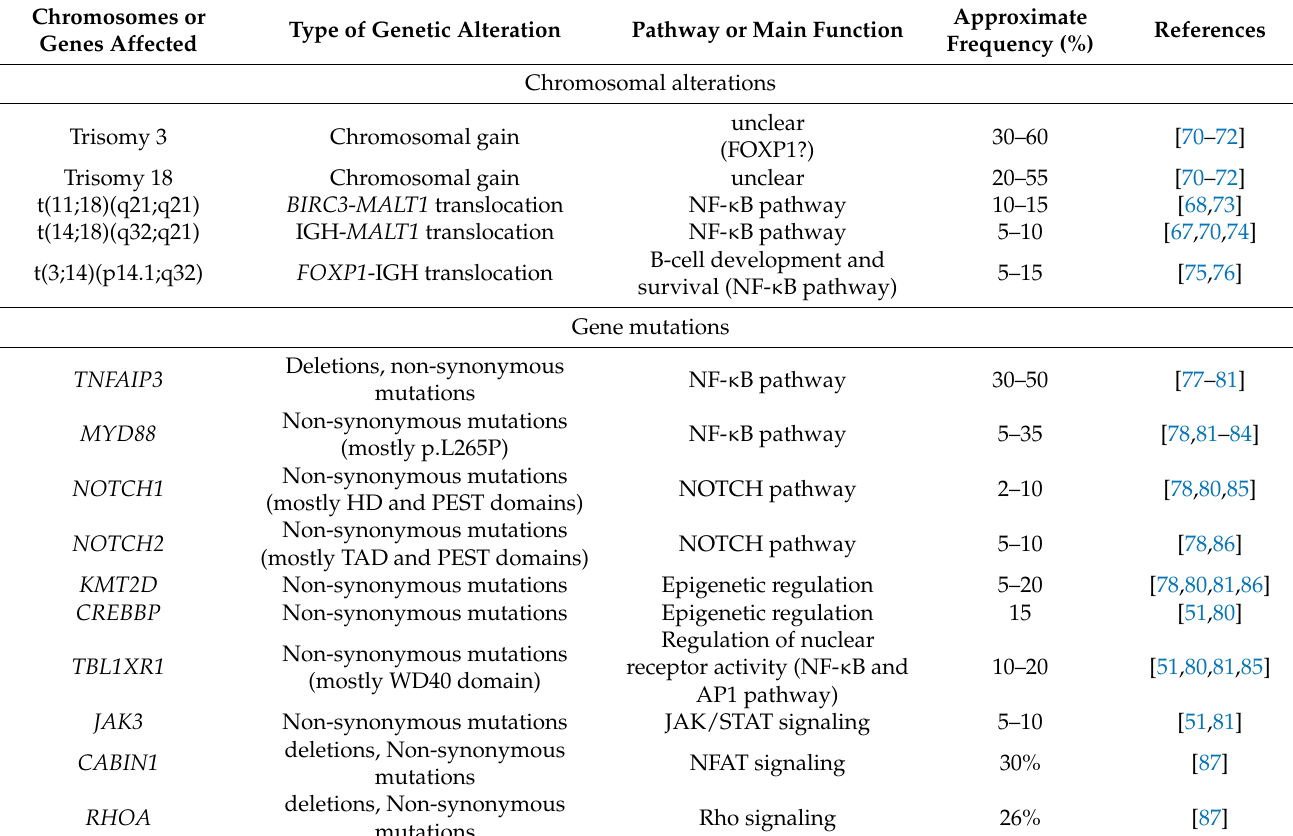
Table 1. Genetic alterations of